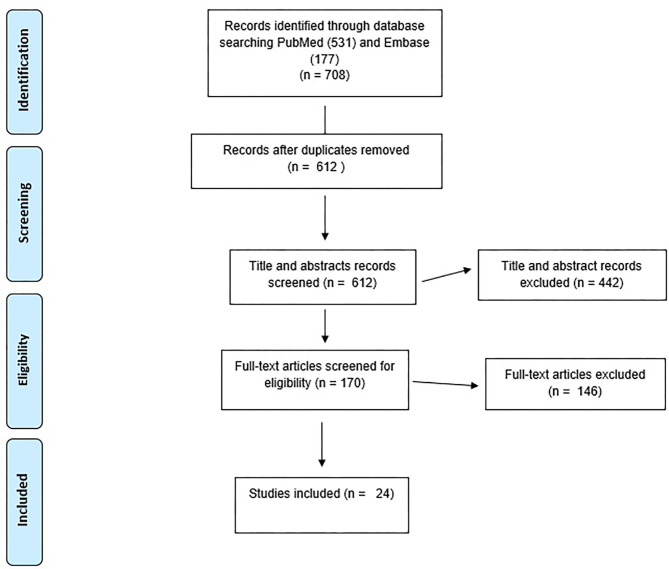
PRISMA flow diagram.